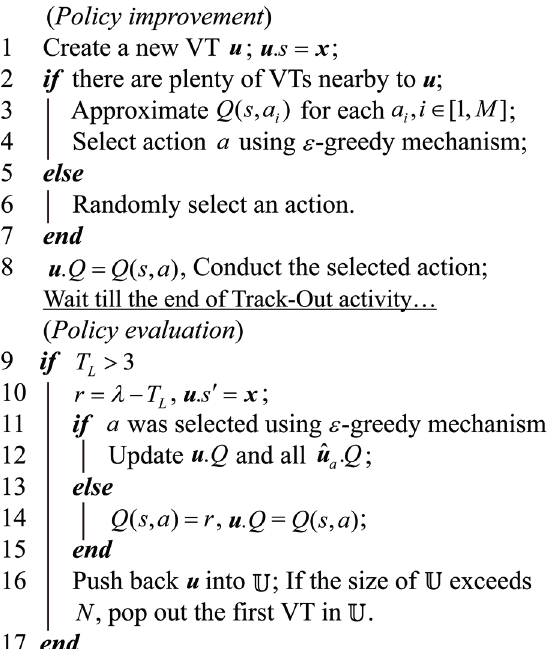
Figure 4. Flow chart of the VTF method.  u s and ˆ VTs associated with action a , respectively.